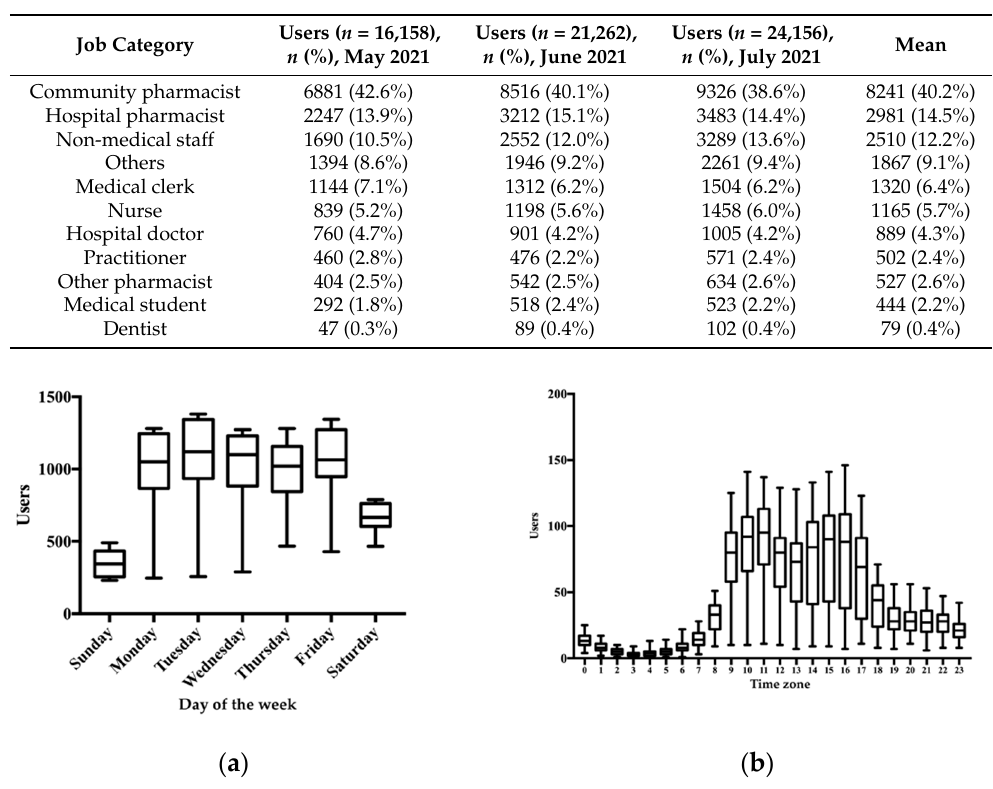
Figure 2. Day of week and time of day the SAGASU-DI was visited: ( a ) access counts of the SAGASU-DI relative to the day of week; ( b ) access counts of the SAGASU-DI relative to the time of day. Table 2. Data collection using Google Analytics.